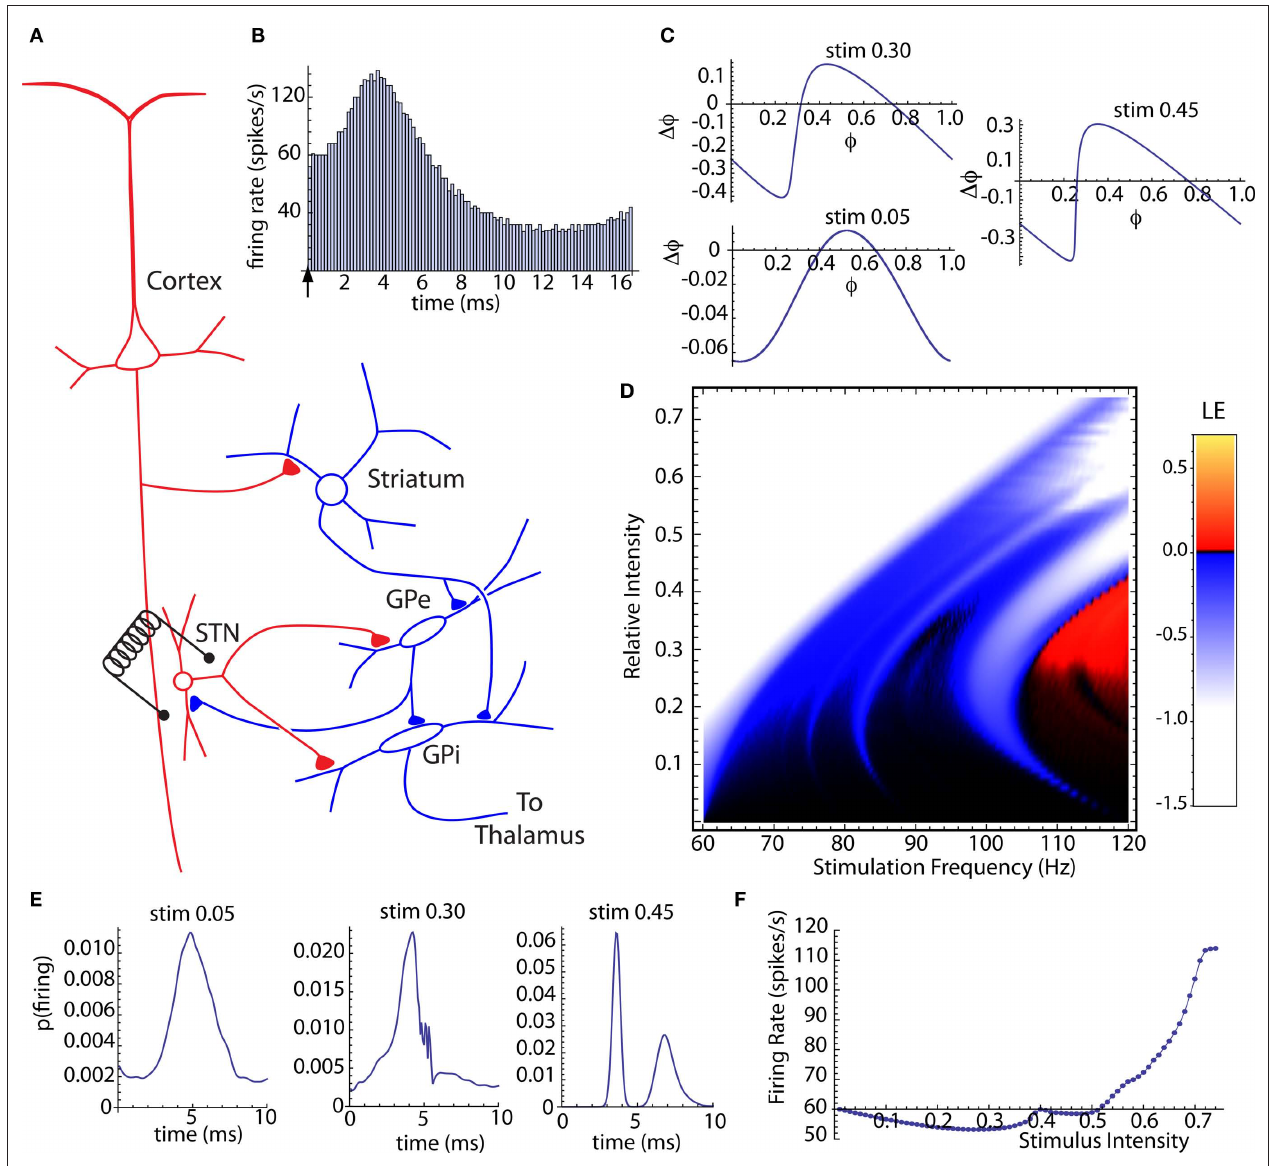
resetting curves for three stimulus intensities. (D) Stimulus intensity and frequency map of Lyapunov exponenents for the stochastic compound subthalamo-pallidal phase map, based on a baseline firing rate of 60 spikes/s. (e) Stationary probability distributions of firing time relative to DBS stimulation at 114 Hz, for the same threestimulus intensities shown in (C) . (F) Steady-state average firing rate during 114 Hz. DBS across the range of stimulus